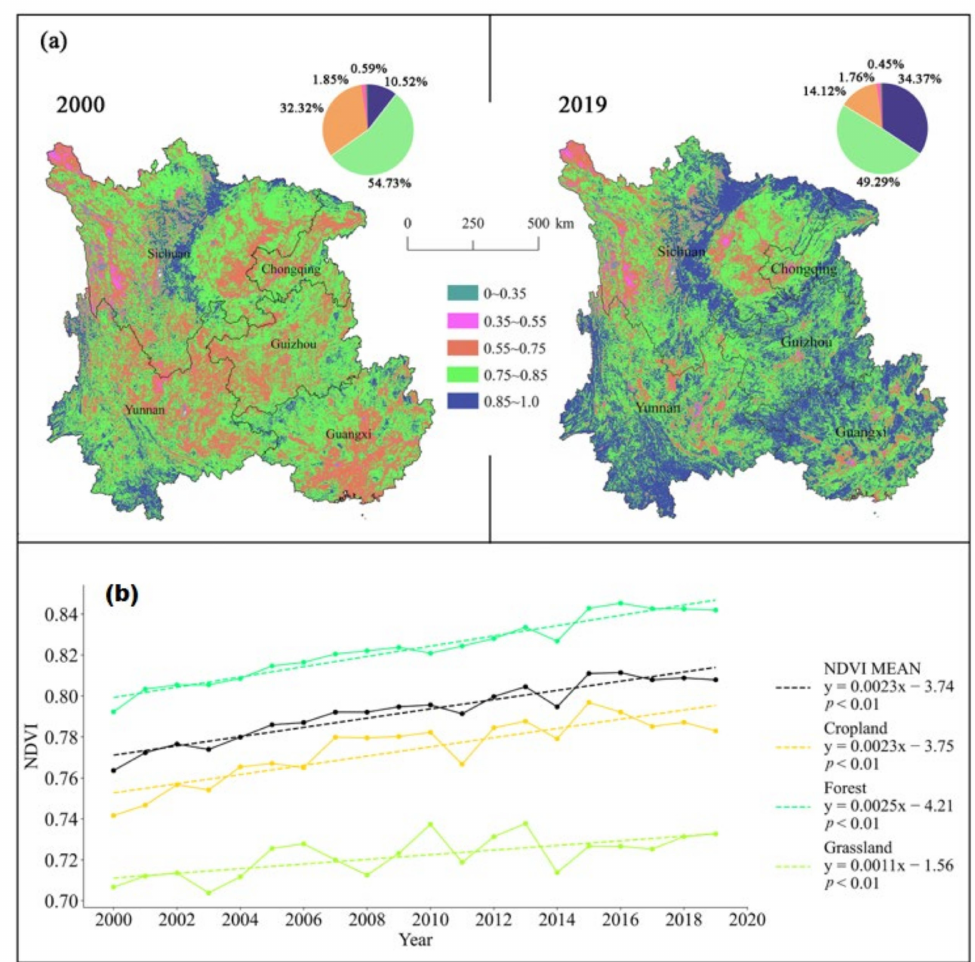
Figure 3. ( a ) Spatial distribution of NDVI in southwest China and ( b ) Changing trends in NDVI values from 2000 to 2019 for different land use